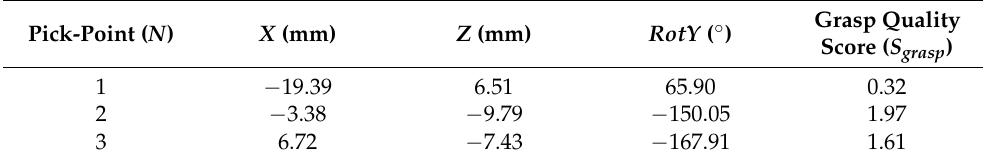
Table 5. Test pick-point location, orientation, and score. Source: own. Pick-Point ( N